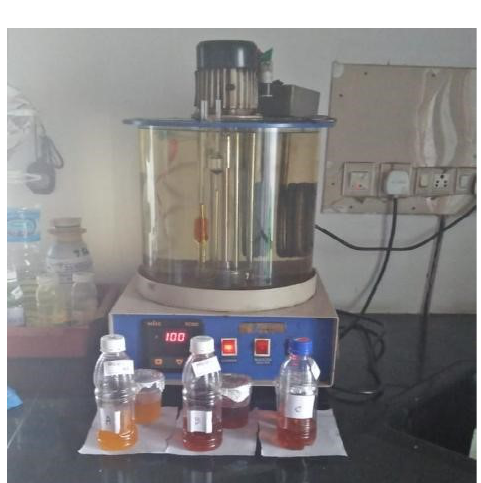
Figure 4: Experimental setup for Pour Point test as per IS: 1448 (Part-10)